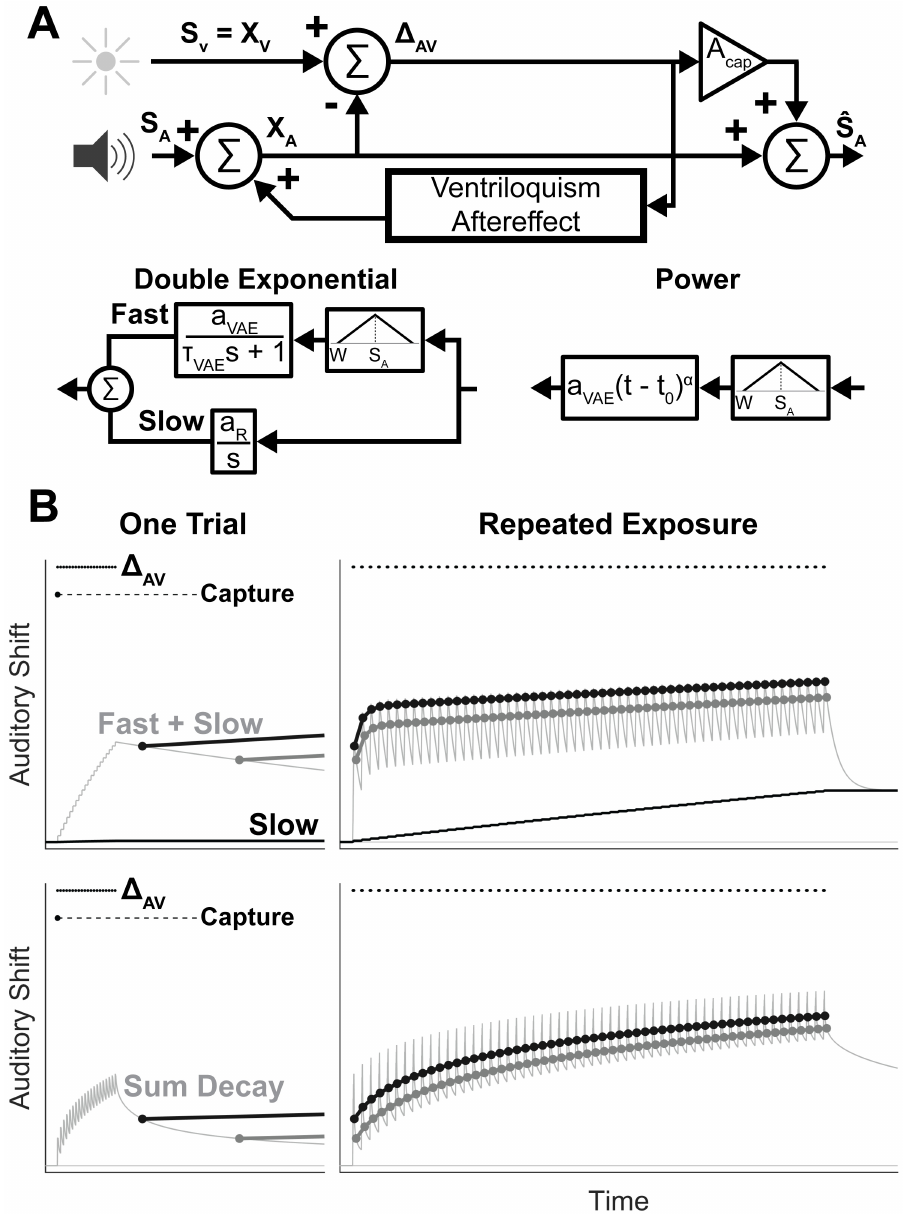
Fig 5. Model of the ventriloquism aftereffect. A , Block diagram summarizing the state-space model, along with the double exponential and power models of the ventriloquism aftereffect. B , Example model responses to AV disparity trains. The top panels show the double exponential model, and the bottom panels show the power model. The left panels show how auditory shift builds and decays to a single AV disparity train (each dot represents a single repetition of the AV disparity). When auditory targets are presented following an AV disparity train, auditory shift influences the encoded location of the target (points and trend lines, colored to match Fig 3). Additionally, visual capture (not measured in the present experiment) occurs within the first AV disparity and can be held in memory indefinitely, as shown in [16]. The right panels show how both models can replicate the trends in auditory shift produced by repeated exposure to a fixed AV disparity observed in Fig 3. In both panels, median best fit model parameters across participants were used to produce the trends shown, to allow for visual comparison of model predictions. The effect of changing spatial location was not shown here to emphasize the changes in temporal relationship across the two models, so the difference in auditory shift across trial types appears smaller than in Fig 3.